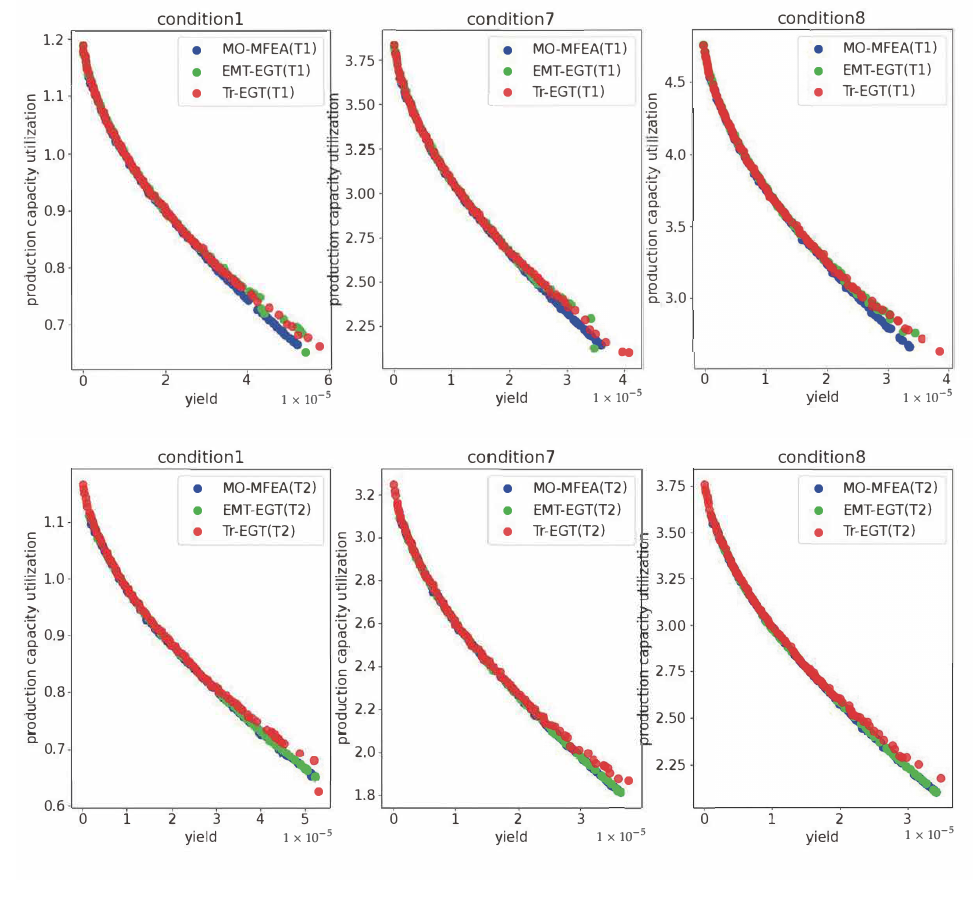
Figure 6. The average approximate PF was obtained by the multitask algorithms under Conditions 1, 7, and 8 over 20 runs in task 1 and task 2